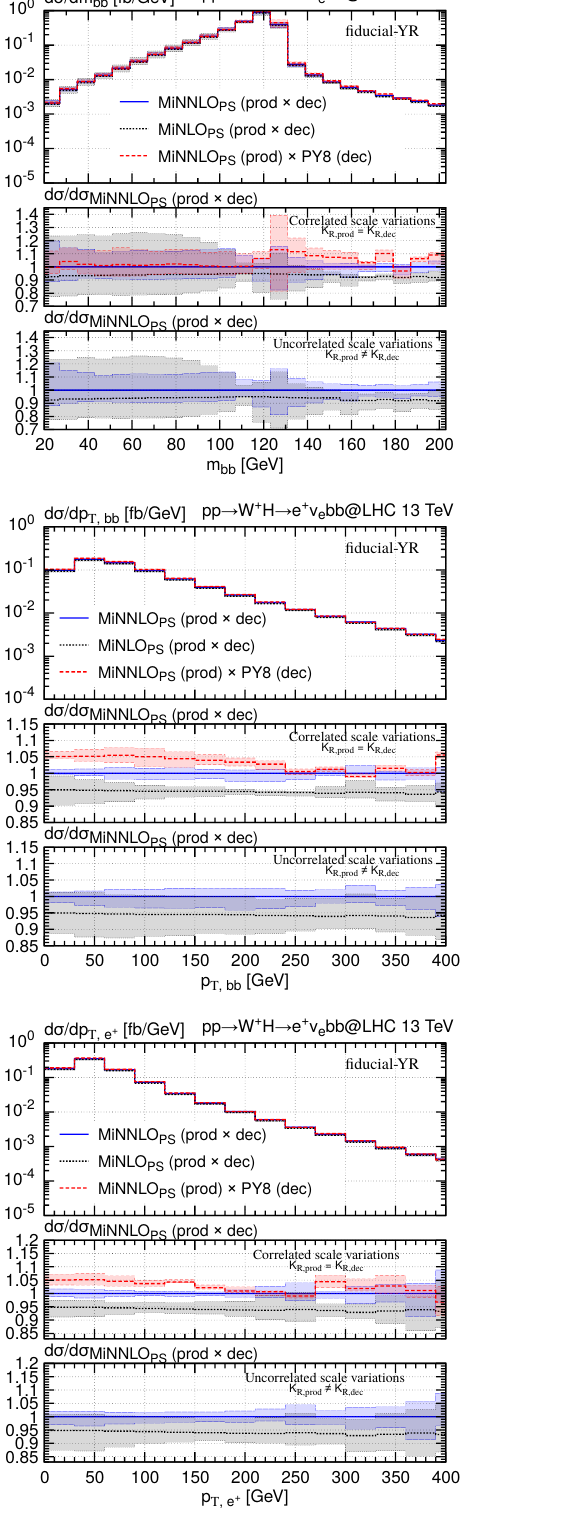
Figure 4 . Differential distributions for e + ν e b ¯ b production with fiducial-YR cuts. K R , prod and K R , dec refer to the variation factors of the renormalization scales of production and decay,